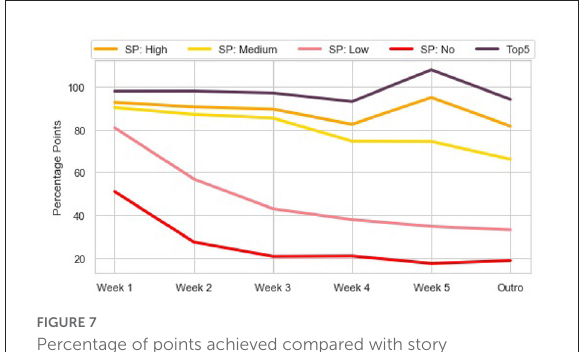
FIGURE7 Percentage of points achieved compared with story participation (SP) and Top 5 performance (Hagedorn et al., 2022). The story participation through the course is visualized for a high (5–6 quizzes), medium (3–4 quizzes), low (1–2 quizzes), and no participation (0 quizzes). In addition to all regular points, week 5 included a few optional bonus points counting toward the Record of Achievement.